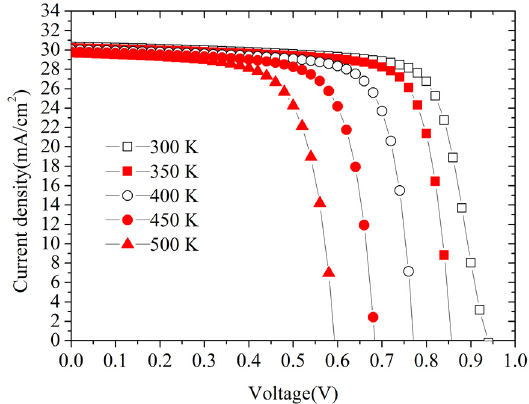
13 of 17 Figure 15. Effect of back-contact work function on PCE. 3.8. Effect of Operating Temperature In general, the operating temperature of solar cells is higher than 300 K. Therefore, in our simulation, the domain of the operating temperature is set from 300 to 500 K to study how the operating temperature influences the cell performance. Figure 16 plots the J-V characteristics of the PSC. As exhibited in that figure, the PSC performance deteriorates as the operating temperature increases. This might be because the increase of operating temperature will cause a decrease in V oc (Equation (7)), and consequently will hurt the PSC performance. 𝑑(𝑉 (cid:3042)(cid:3030) ) 𝑑𝑇 = (cid:3436)𝑉 (cid:3042)(cid:3030) − 𝐸 (cid:3034) 𝑞 (cid:3440) 𝑇